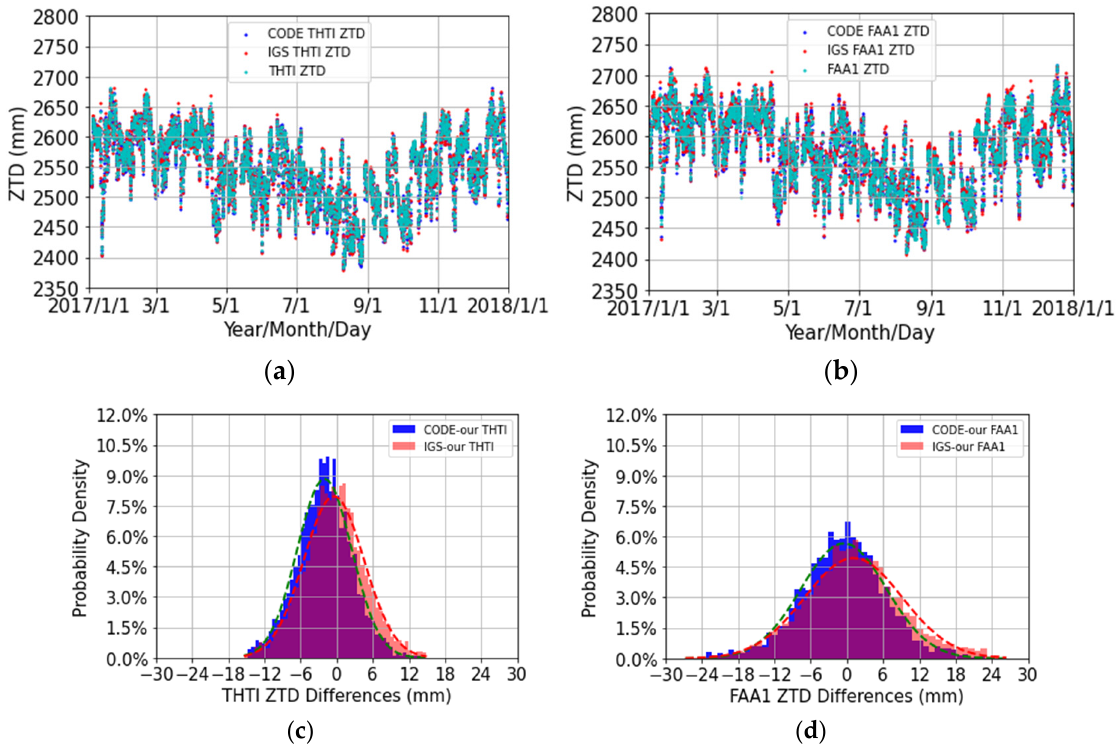
Figure 2. Comparisons of our THTI ZTD estimates (cyan dots) with CODE/IGS THTI ZTD estimates (blue and red dots) ( a ), and FAA1 ZTD estimates (cyan dots), with CODE/IGS FAA1 ZTD estimates (blue and red dots) ( b ). See Table 2 for a statistical summary; ( c ) histograms of the ZTD differences between our THTI ZTD estimates and CODE/IGS THTI ZTD estimates; ( d ) histograms of the ZTD differences between our FAA1 ZTD estimates and CODE/IGS FAA1 ZTD estimates. Table 2. Statistical summary for the comparison between our THTI/FAA1 ZTD estimates and terms of maximum (max), minimum (min), bias, root mean squares (RMS), and standard deviation (STD). The exact definitions of bias, RMS and STD, are shown in Appendix A.